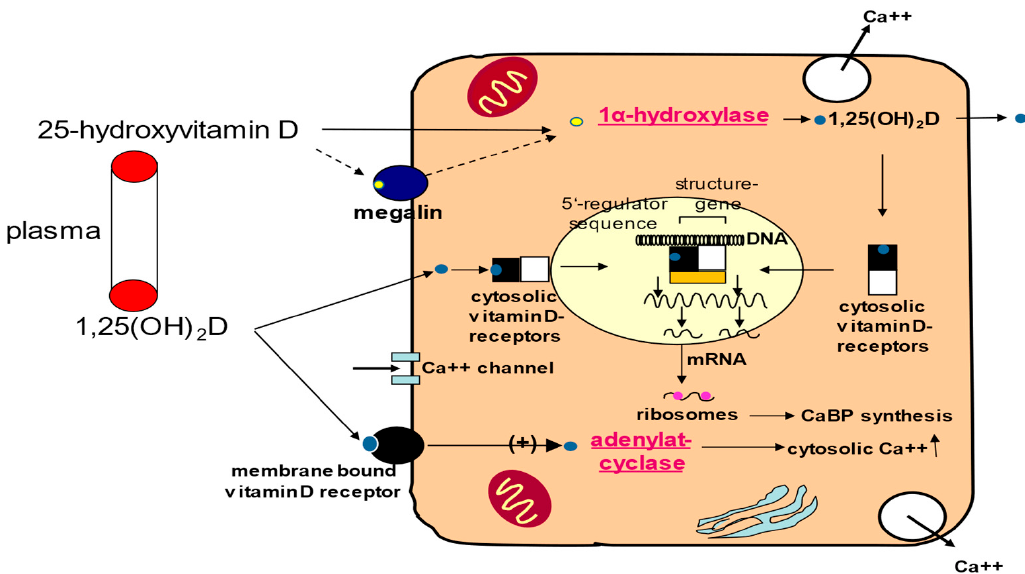
Figure 2. Proposed effects of vitamin D signaling in cardiomyocytes by rapid non-genomic and genomic effects via membrane-bound and cytosolic vitamin D receptors, respectively. Cytosolic binding of 1,25(OH) 2 D leads to hetero-dimerization of the vitamin D receptor (black rectangle) with the retinoid X receptor (white rectangle), and ultimately to translocation of this complex into the nucleus, where it binds to vitamin D response elements (orange rectangle). Additionally, 1,25(OH) 2 D may be produced locally by the internalization of 25(OH)D via diffusion or a vitamin D receptor (VDR)-independent, megalin–cubilin-mediated process (hypothetical). Non-genomic effects of 1,25(OH) 2 D result in the rapid release of ionized calcium from intracellular stores, whereas genomic effects result in calcium-binding protein (CaBP) synthesis. Locally produced 1,25(OH) 2 D may also exhibit paracrine actions. Yellow circle, 25(OH)D; blue circle, 1,25(OH) 2